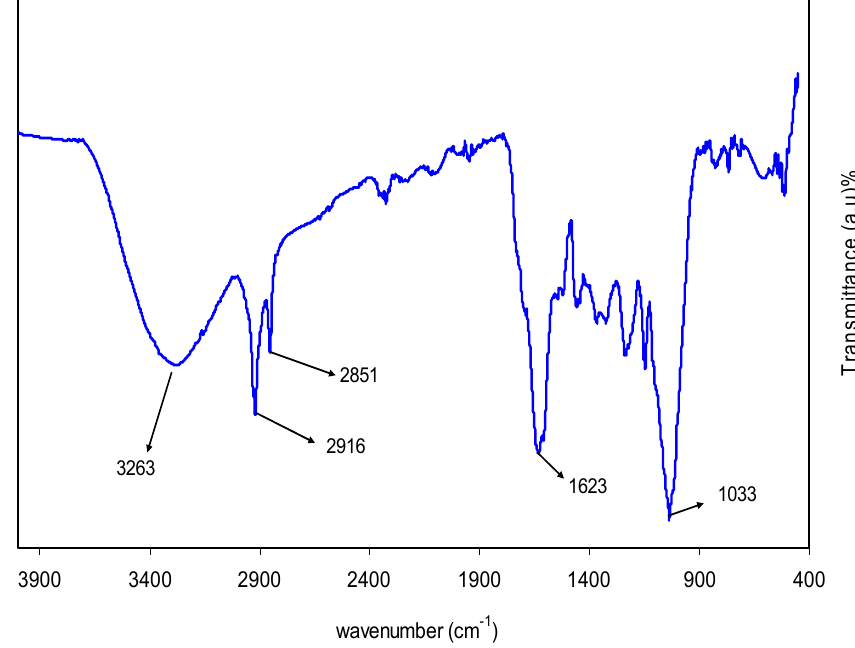
Figure 1. FTIR spectra of black tea leaves.